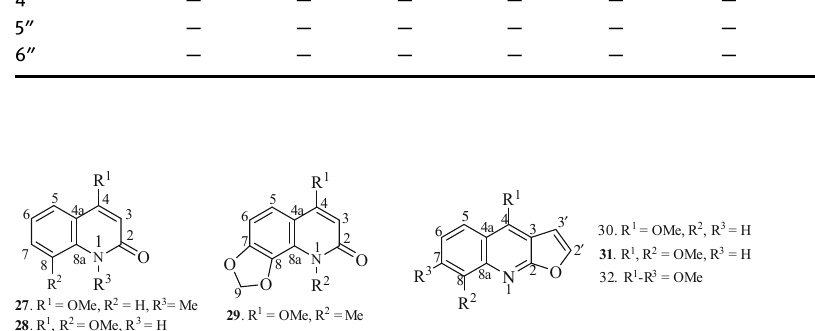
Figure 4: Structures of quinolone alkaloids from Casimiroa .